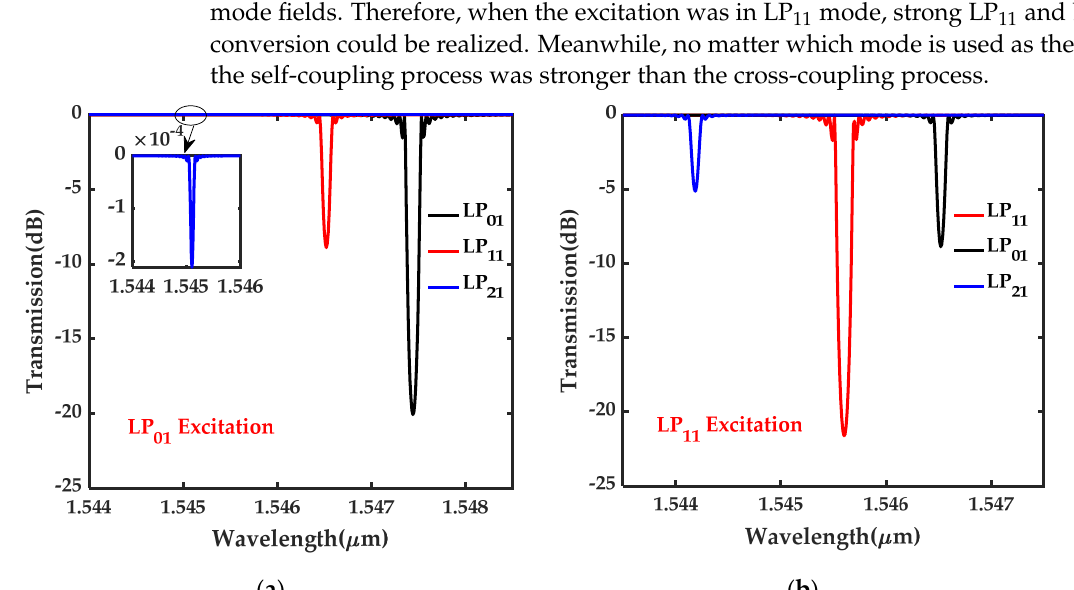
Figure 3. Transmission spectra of the few-mode fiber Bragg grating (FM-FBG) when the excitation was ( a ) LP 01 mode and ( b ) LP 11 mode.